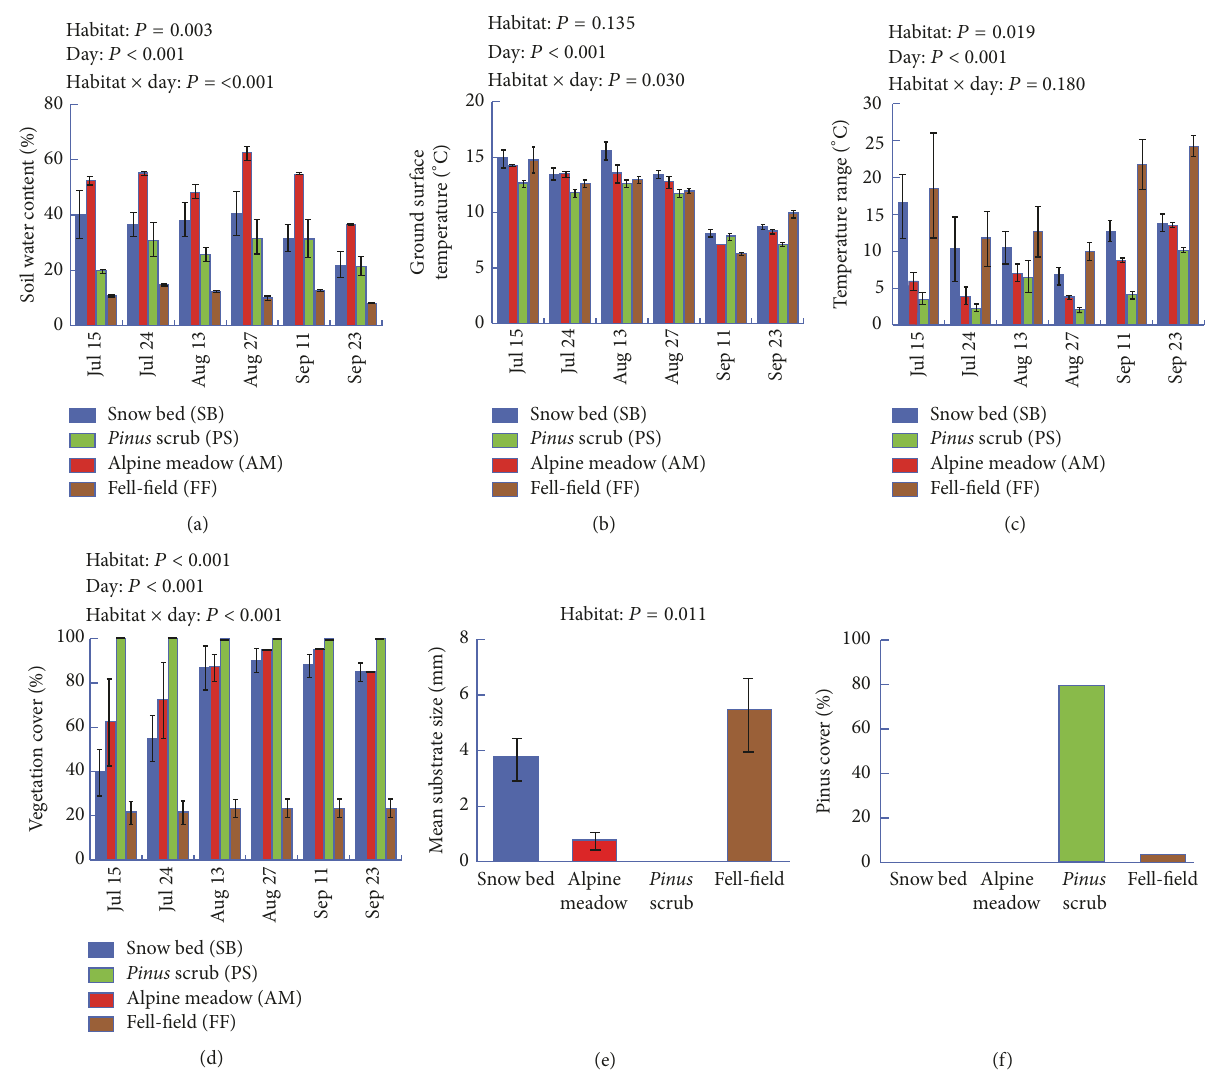
Figure 2: Soil water content (a), ground surface temperature (b), diurnal temperature range (c), vegetation cover (d), mean substrate size (e), and Pinus cover (f) in four habitats of the alpine-subalpine zone on Mt. Hakusan in central Japan. The 𝑃 values are based on the results of repeated measures ANOVA (soil water content, ground surface temperature, diurnal temperature range, and vegetation cover) and one-way ANOVA (mean substrate size) testing for differences in environmental variables among the four habitats. The difference in Pinus cover among the four habitats could not be tested using factorial ANOVA. Data are presented as means ±